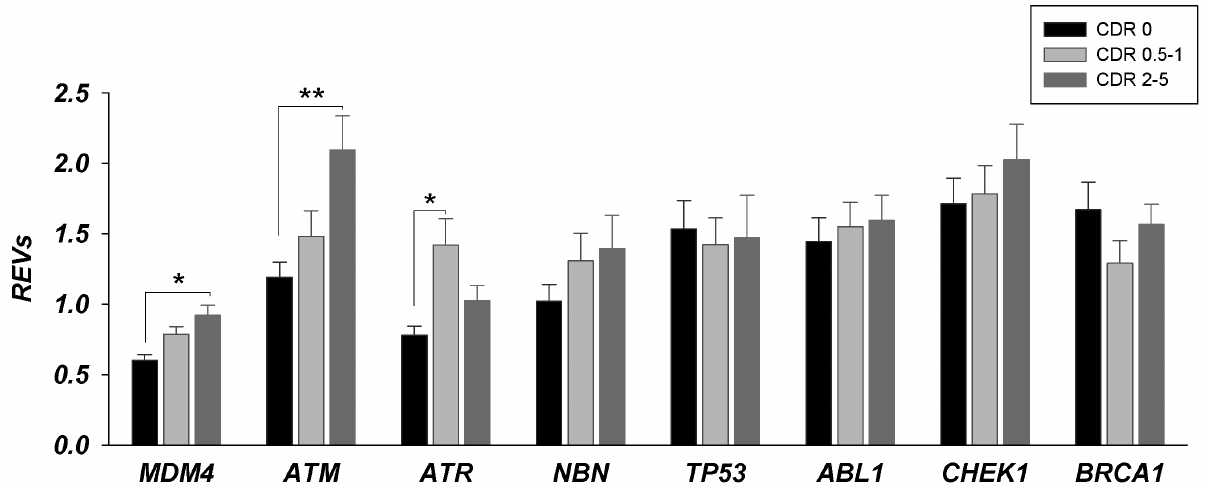
Figure 2. Gene expression changes for ATM/ATR signaling pathway in STG (BA22) during progression of dementia (as a function of CDR). MDM4, ATM and ATR gene expression levels were significantly different in questionable-mild (CDR 0.5-1, light gray bars) and severe (CDR 2-5, dark gray bars) dementia groups relative to control group (black bars). REVs- relative expression values; * -p , 0.05; ** -p # 0.01.